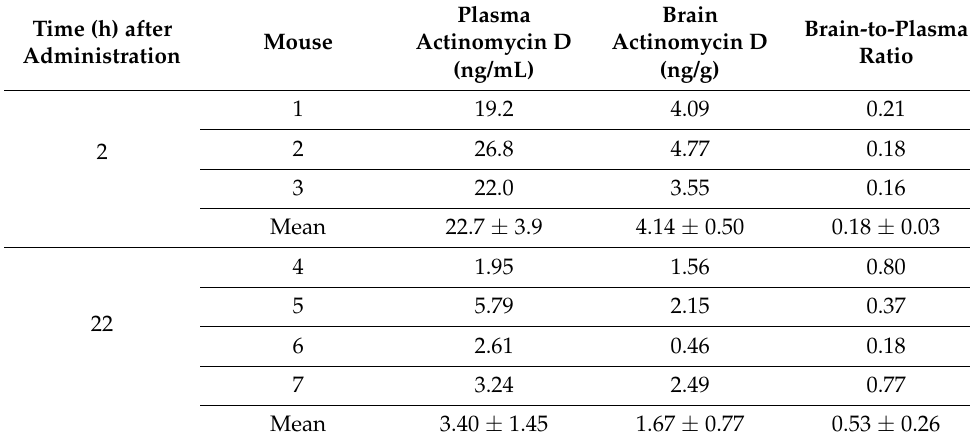
Table 2. Plasma and brain concentrations of mice 2 and 22 h after intravenous administration of 0.5 mg/kg actinomycin